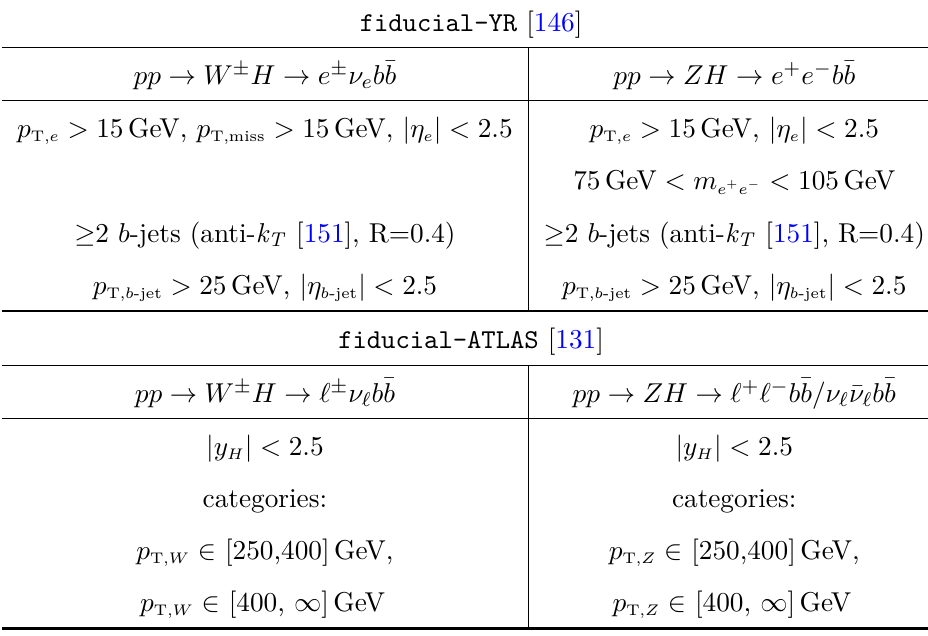
Table 2 . Fiducial cuts used in the setup fiducial-YR and setup fiducial-ATLAS